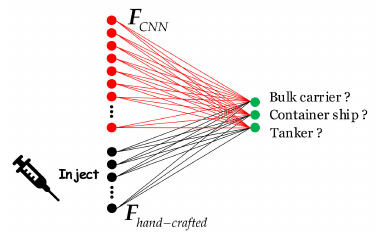
Figure 11. Diagrammatic sketch of the concatenation